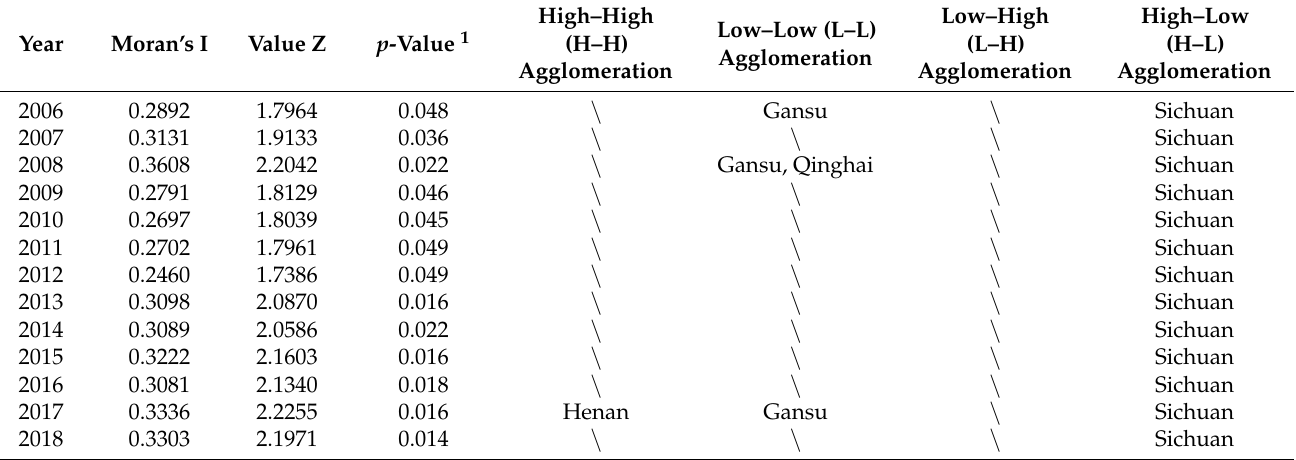
Table 3. Global Moran index measurement results of the co-benefits of carbon reduction and air pollution control in the